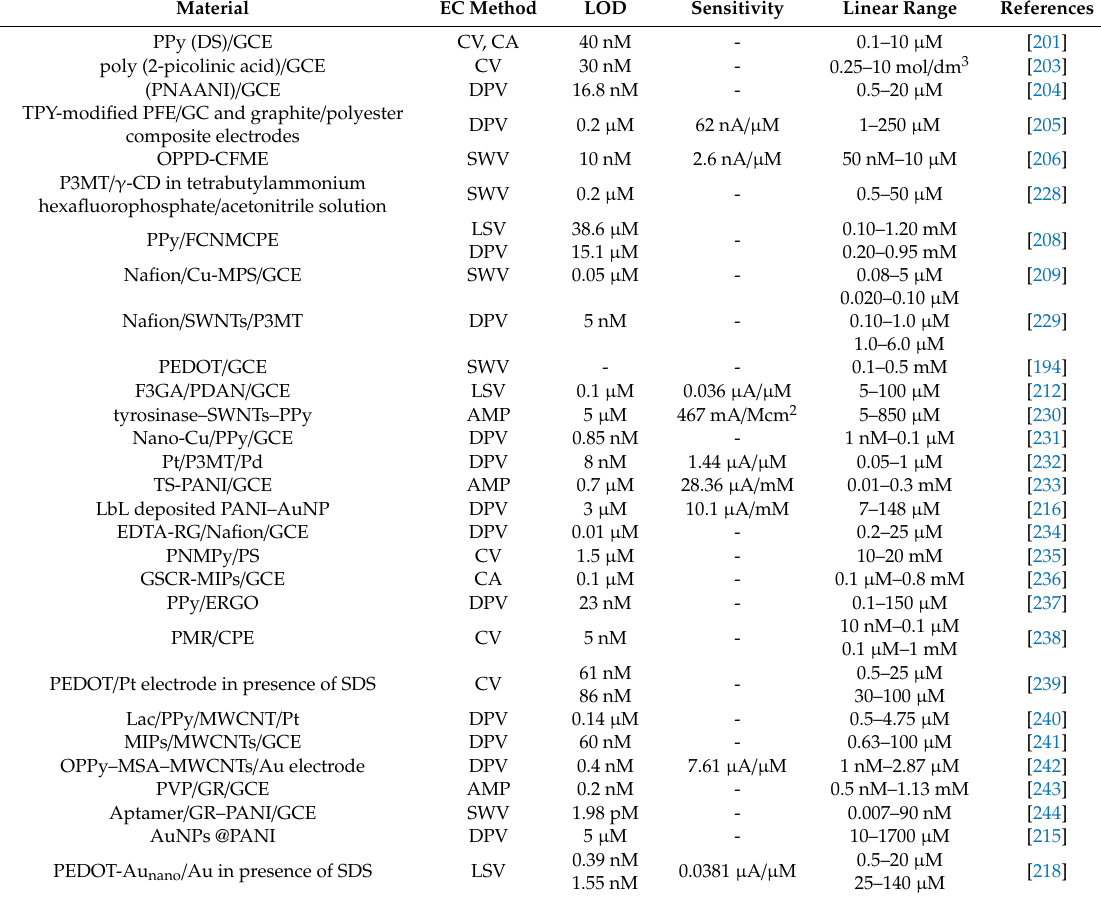
Table 2. Polymer-based EC sensor for DA